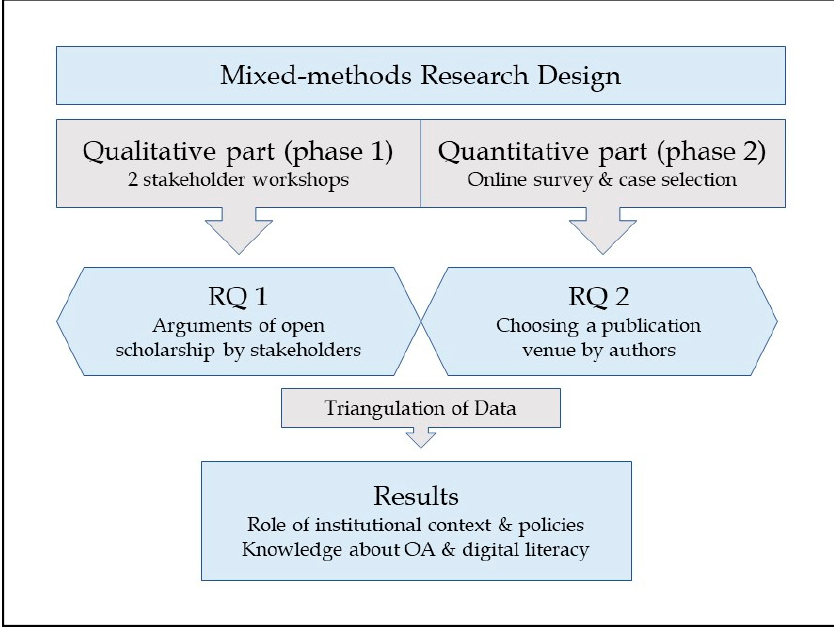
Figure 1. Research Design.